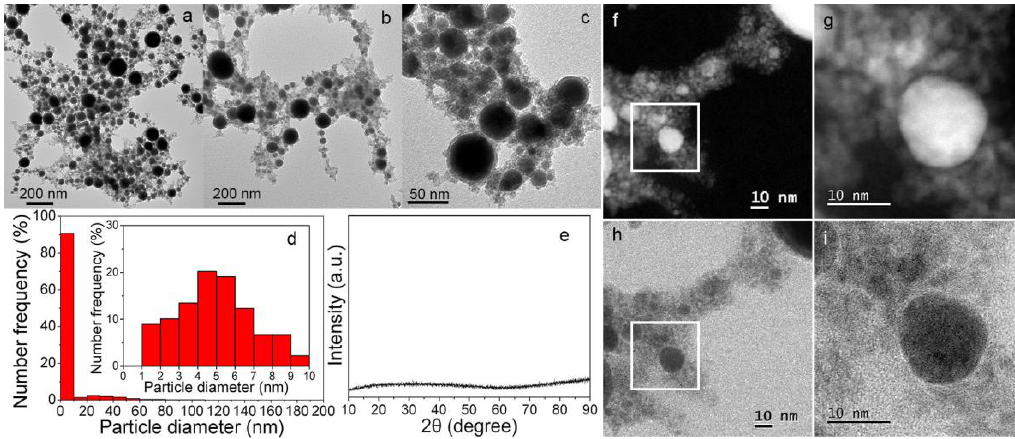
Figure 1. ( a – c ) TEM images of the particles synthesized by the laser ablation of Fe in acetone at 400 mW. ( d ) Size distribution of the synthesized particles. The inset figure shows the detailed size distribution in the range of 0 – 10 nm. ( e ) XRD pattern of the synthesized particles, where no peaks were detected, probably due to the low crystallinity of the particles and a large amount of carbon clusters. ( f , g ) and ( h , i ) black field and white field scanning transmission electron microscopy (STEM) images of small particles, respectively.